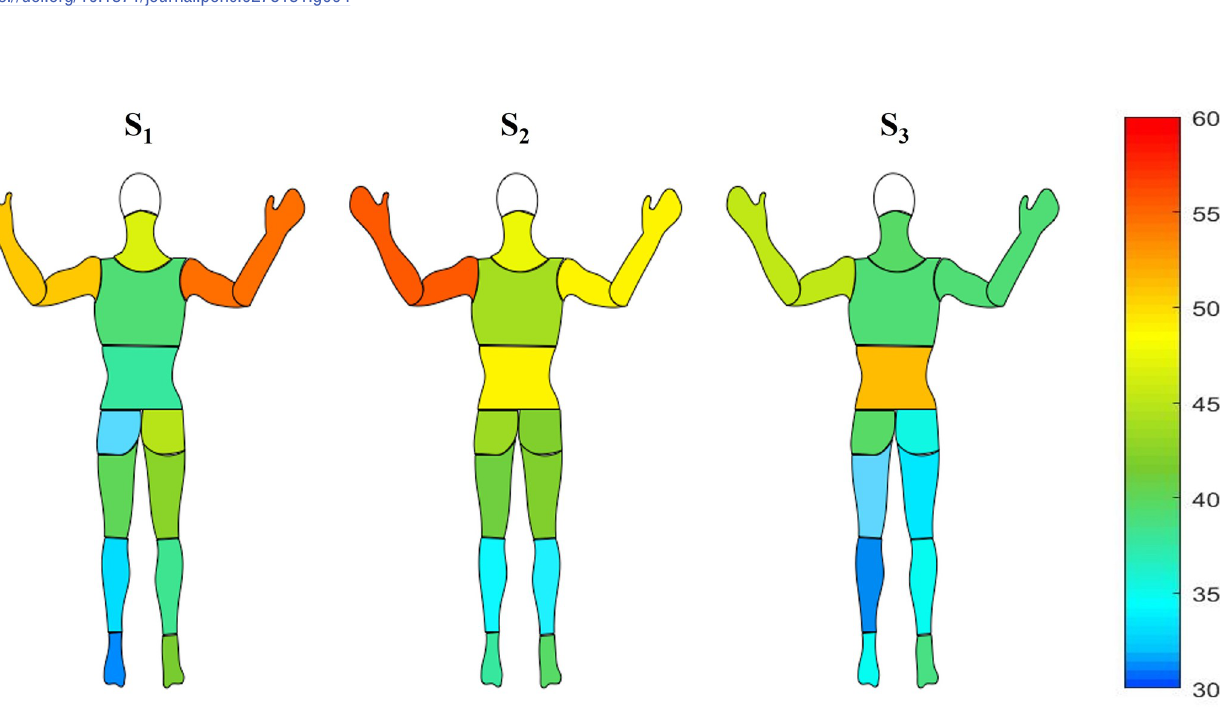
PLOS ONE | https://doi.org/10.1371/journal.pone.0278131 December12,